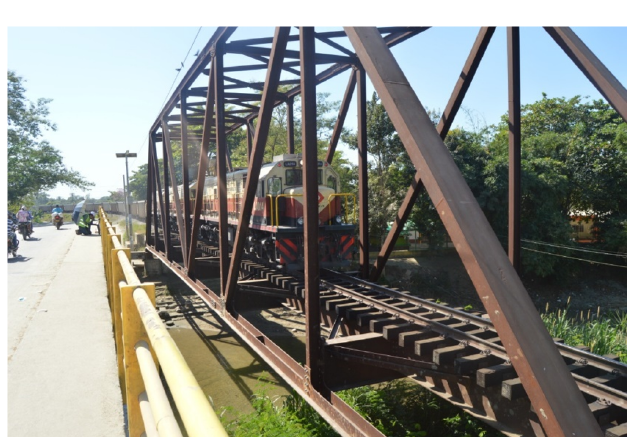
Figure 8. Steel structure of the railway bridge.